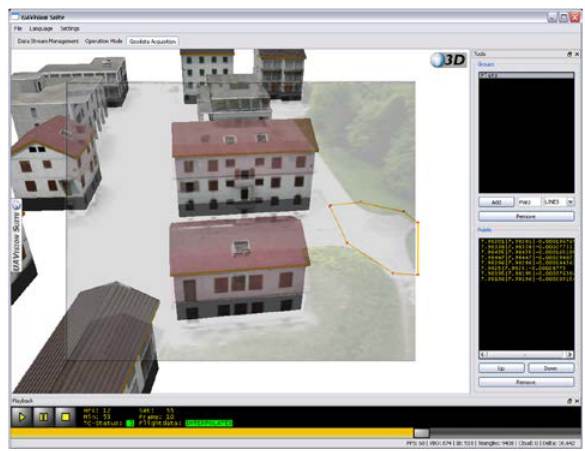
Figure 5: Augmented Monitoring with integrated mapping functionality